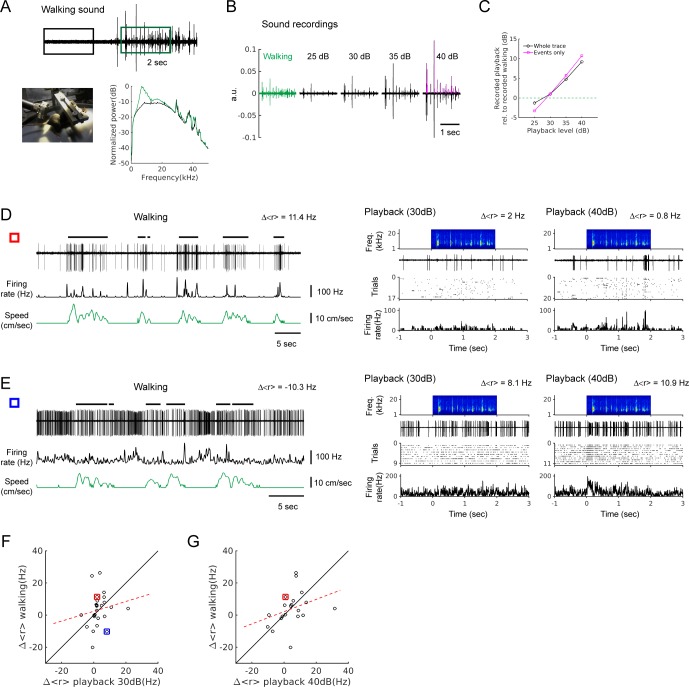
Recording of walking sounds and playback responses.(A) Top: walking sound recording in sound pressure waveforms (black and green boxes denote 2 sec periods during baseline and walking, respectively, used for power spectrum calculation and playback). Bottom left: picture of the recording setup. Bottom right: normalized power spectrum (black trace: baseline, green trace: walking). (B) Recordings of walking sound (green), and walking sound playback at different sound levels (25, 30, 35, and 40 dB). The playback sound levels were determined from RMS values of thresholded events shown as magenta in the 40 dB waveform. (C) Sound levels of recorded playbacks in B, relative to the level of the walking sound recording (horizontal green dashed line). Sound levels were obtained from whole traces (black) or only from the events (magenta), In both cases, the recording of 30 dB playback was the closest to that of walking sounds. The same events were used for all playback levels and walking sound recording. (D) Example neuron showing a strong positive modulation during locomotion (left; ∆<r> = 11.4 Hz), but weak responses to playback (right; ∆<r> = 2.0 Hz at 30 dB, and ∆<r> = 0.8 Hz at 40 dB). (E) Example neuron showing a suppression during locomotion (left; ∆<r> = −10.3 Hz), but excitatory responses to playback (right, ∆<r> = 8.1 Hz at 30 dB and ∆<r> = 10.9 Hz at 40 dB; in this example, the first 0.5 s of the stimulus period was excluded for firing rate measurement due to the response during the initial baseline period). (F) Average firing rate changes (∆<r> ) during locomotion vs. the changes by walking sound playback at 30 dB (n = 25; r = 0.16, p=0.44). Red and blue squares represent the neurons in D and E, respectively. (G) Same as F, but for playback at 40 dB (n = 20, five neurons excluded due to substantial responses to the recording baseline; r = 0.33, p=0.15). Red square is the neuron in D. The neuron in E was one of the five excluded neurons.